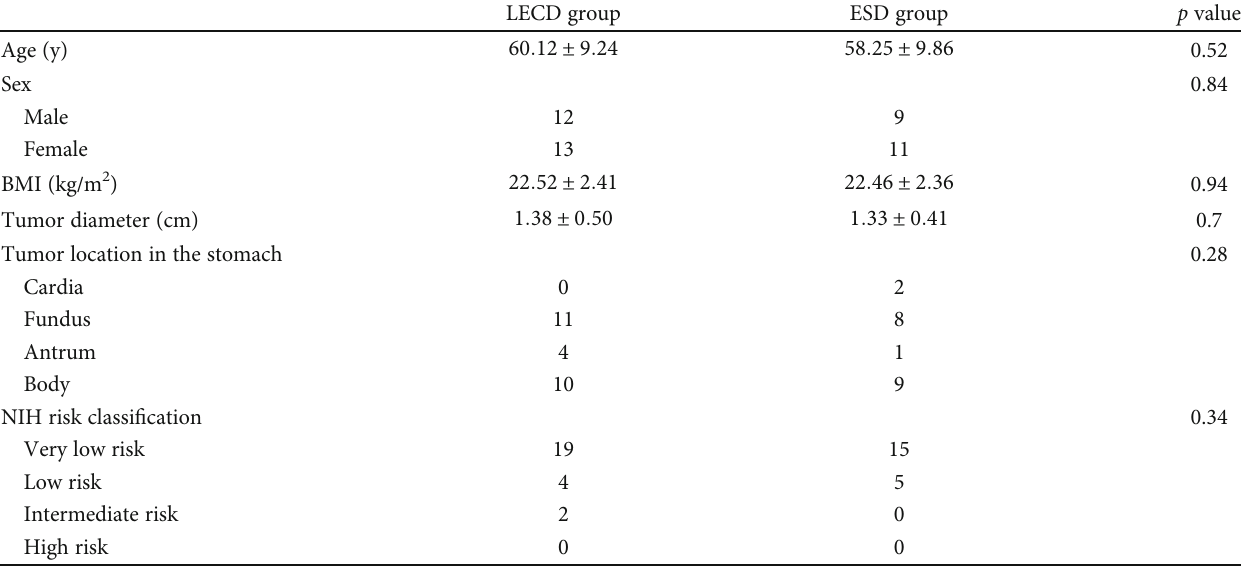
Table 1: Comparison of general data between LECD group and ESD group.